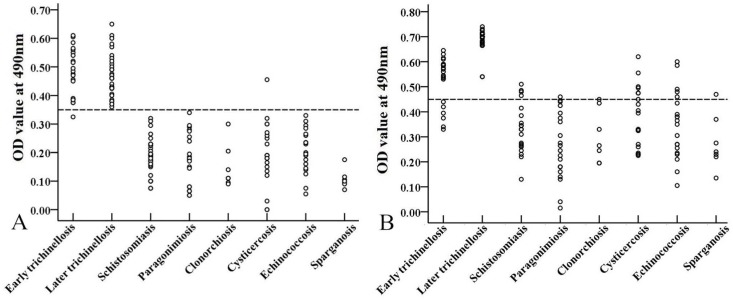
Scatter plot of optical density values of rTsSP-ELISA (A) and ES-ELISA (B) for detection of anti-Trichinella IgG in serum samples of patients with trichinellosis and other parasitic diseases. The cut-off value is represented by the dotted line.